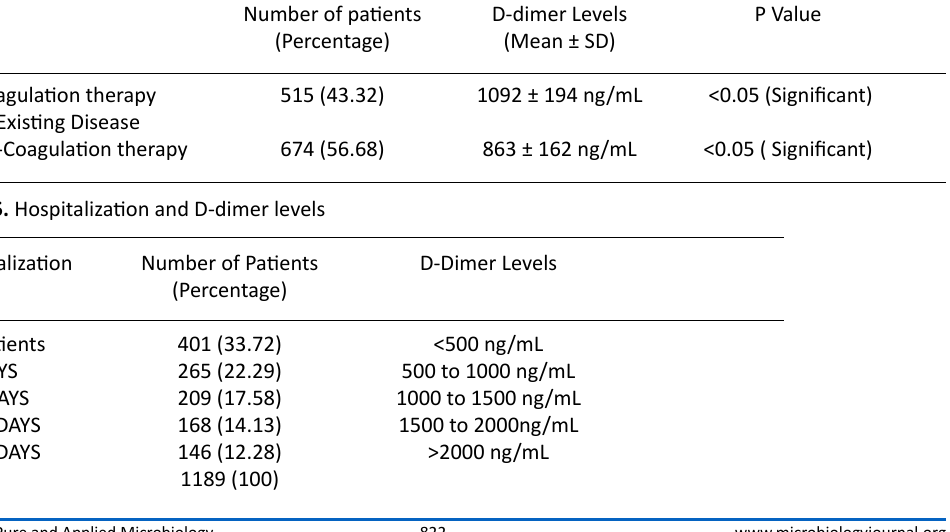
Table 4. D-dimer levels comparison with anti-coagulation therapy